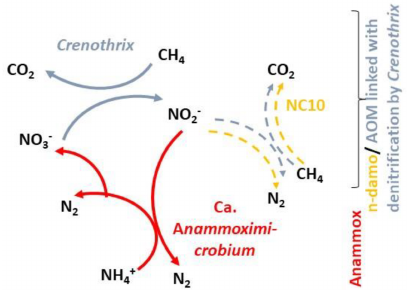
Figure 6. Conceptual model of the coupled N and C cycles in the anoxic water column of